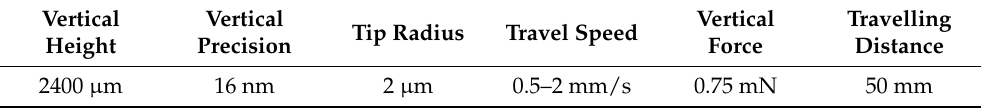
Table 1. Profilometer